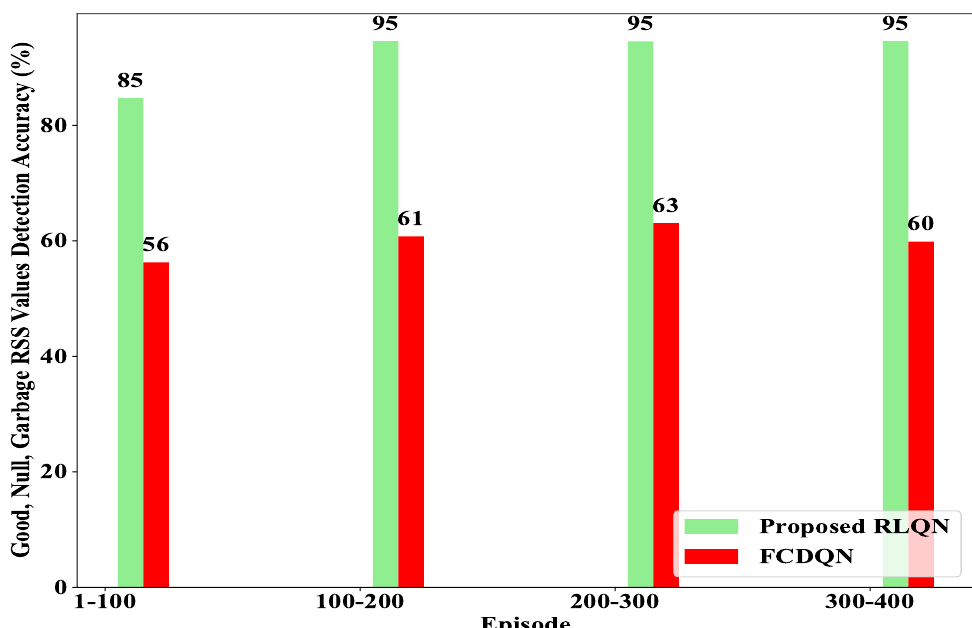
Figure 9. Detection accuracy for each episode